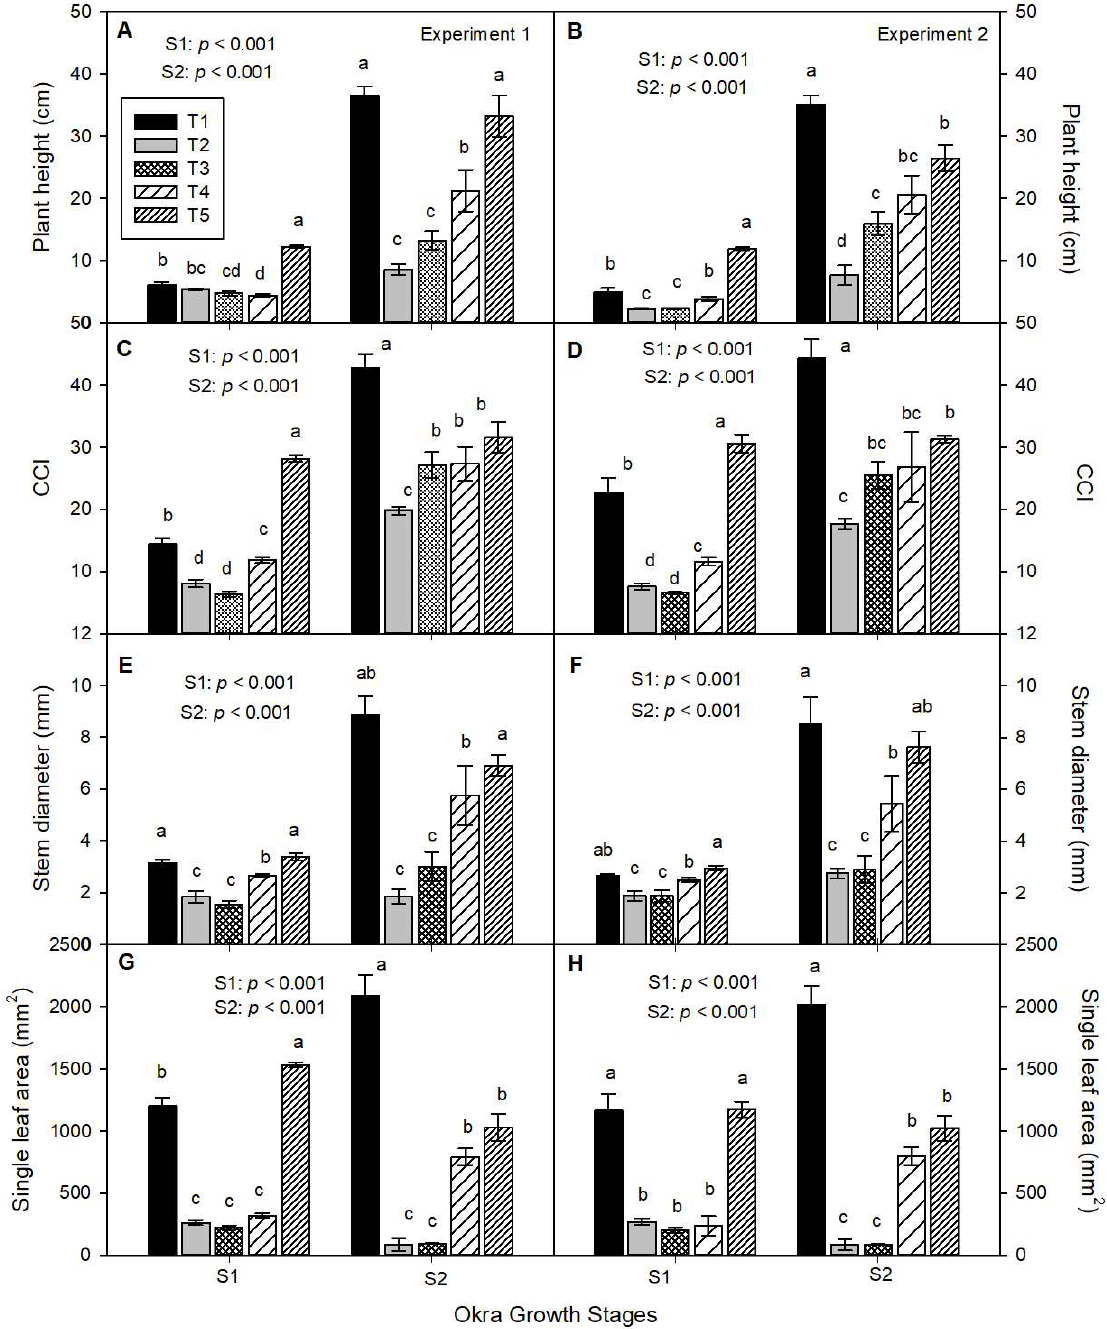
Figure 1. Effects of non-composted Bombax ceiba (red cotton tree) sawdust mixtures on Abelmoschus esculentus L. (okra). Height of plant (cm) ( A , B ), chlorophyll content index ( C , D ), the diameter of the stem (mm) ( E , F ), and single leaf area (mm 2 ) ( G , H ) in two independent experiments. T 1 : unfertilized 100% sandy clay loam soil (control) ( v / v ); T 2 : non-composted 100% B. ceiba sawdust ( v / v ); T 3 : non- composted 80% B. ceiba sawdust + 20% banana peels ( v / v ); T 4 : non-composted 60% B. ceiba sawdust + 20% banana peels + 20% eggshells ( v / v ); T 5 : non-composted 60% B. ceiba sawdust + 20% banana peels + 20% eggshells ( v/v ) + urea (@ 91 kg N ha − 1 ). Different letters display significant differences between treatment mean values at the top of the vertical bars, as determined by the least significant difference test (LSD) at p < 0.05. Differences between treatments were very significant, as evidenced by the p < 0.001. The error bars show the standard error ( n =